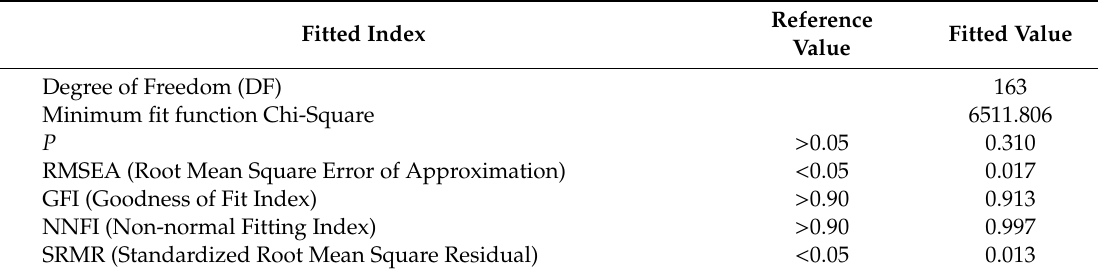
Table 3. Structural equation model fitting result in Amos.